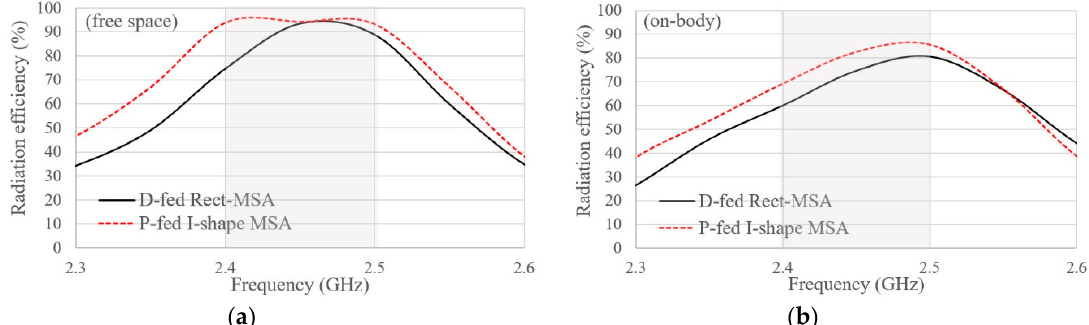
Figure 10. Radiation efficient of P-fed I-shape MSA and D-fed Rect-MSA backed by conductor plate. ( a ) Antennas in the free space; ( b ) antennas on the human body.